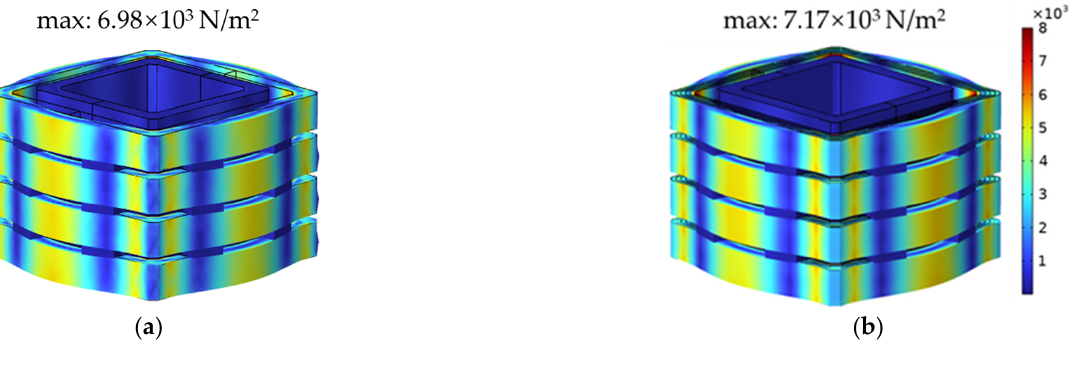
Figure 12. Stress distribution under normal condition ( a ) Interleaved winding; ( b ) Continuous winding.